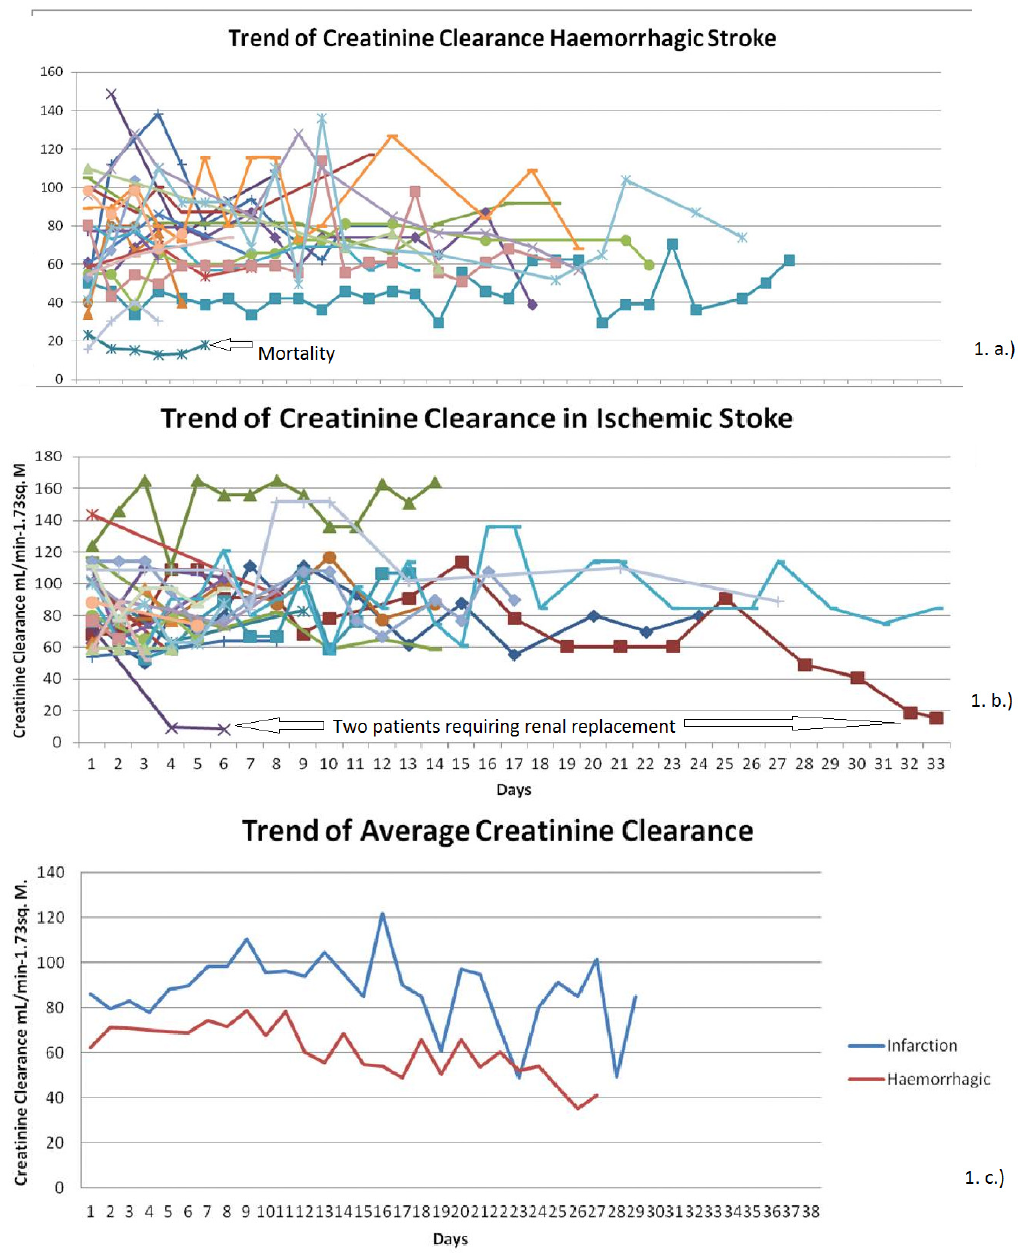
Figure 1. Trends of e-GFR in patients with ( A ) hemorrhagic and ( B ) ischemic stroke. ( C ) Trend of average e-GFR.